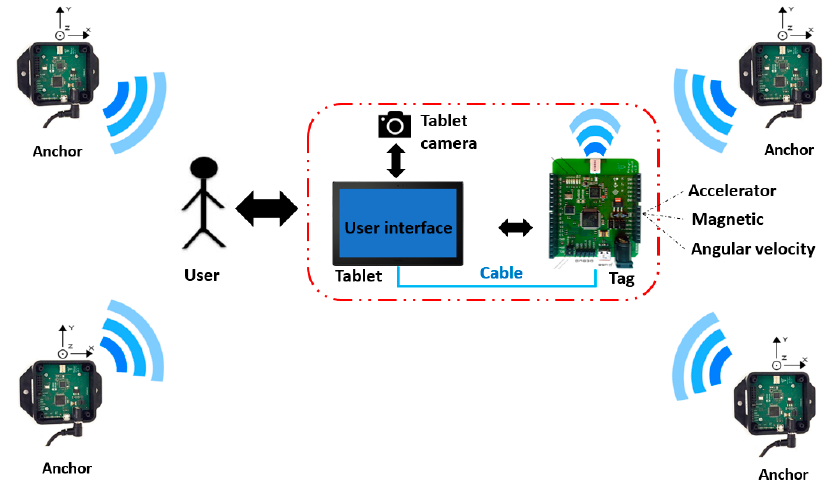
Figure 9. Positioning and orientation system architecture.